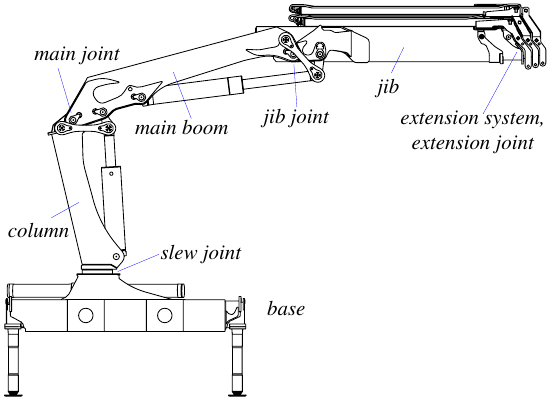
Figure 1: HMF 2020K4 loader crane.